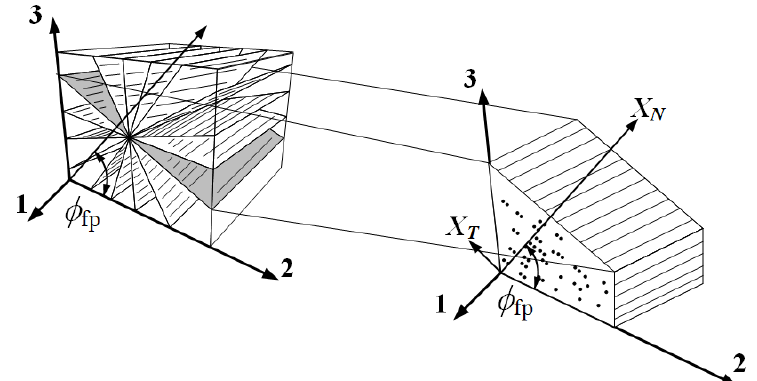
Figure 5. Search of fracture planes based on [31].